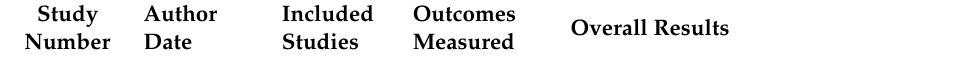
Table 1. Risks of smoking for pregnant women.